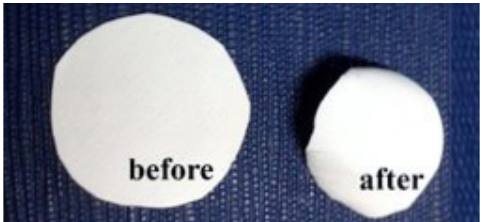
FIGURE 1 - Naftifine-loaded PVA/SA nanofiber mats before and after the crosslinking